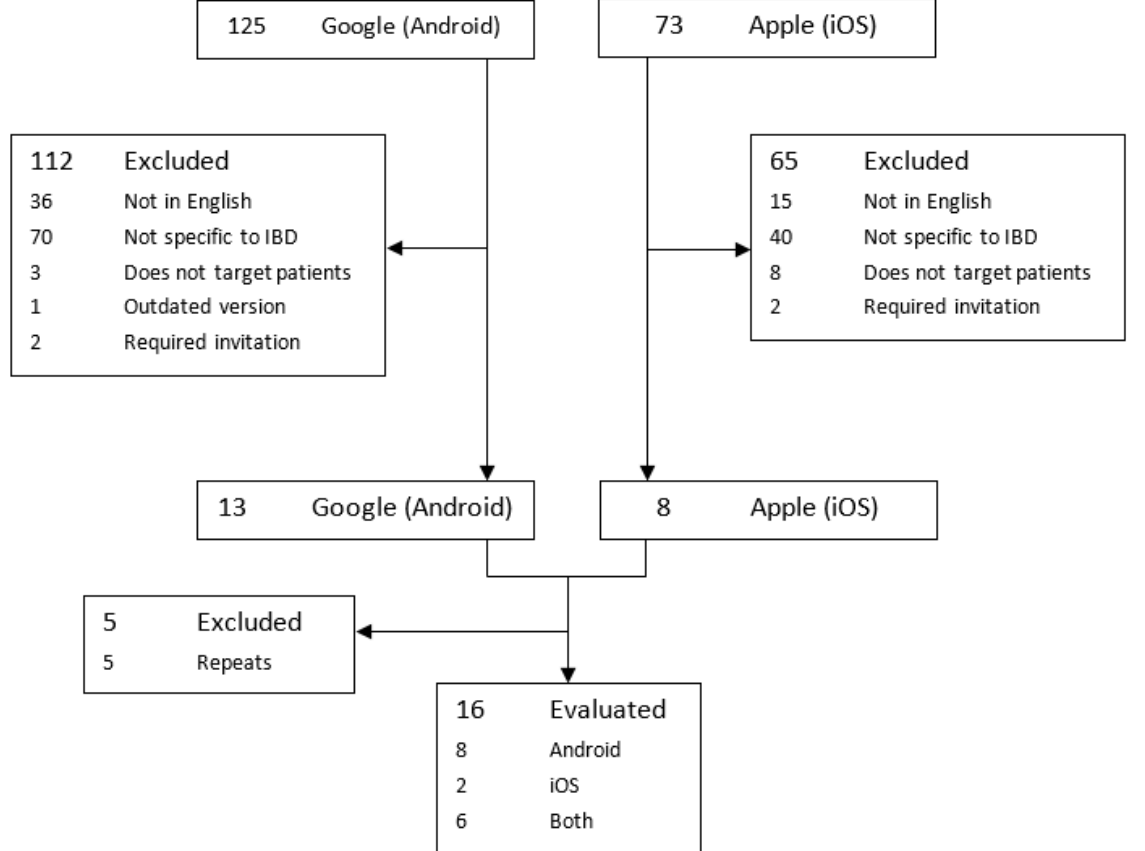
Figure 1. Flow diagram of search and selection process of